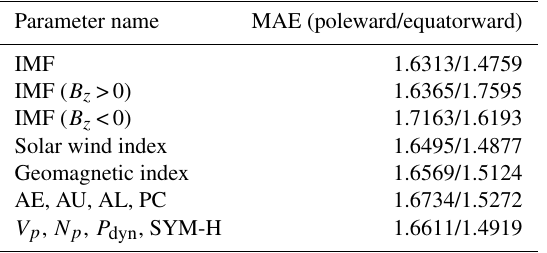
Table 5. The MAE influenced by different combinations of space physical parameters.